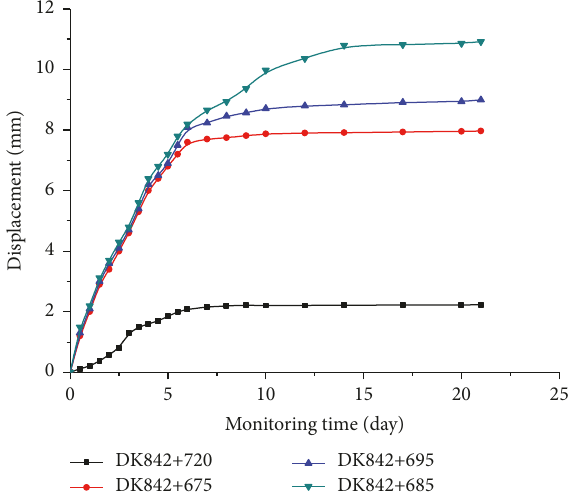
Figure 21: The subsidence change of tunnel surrounding rock.